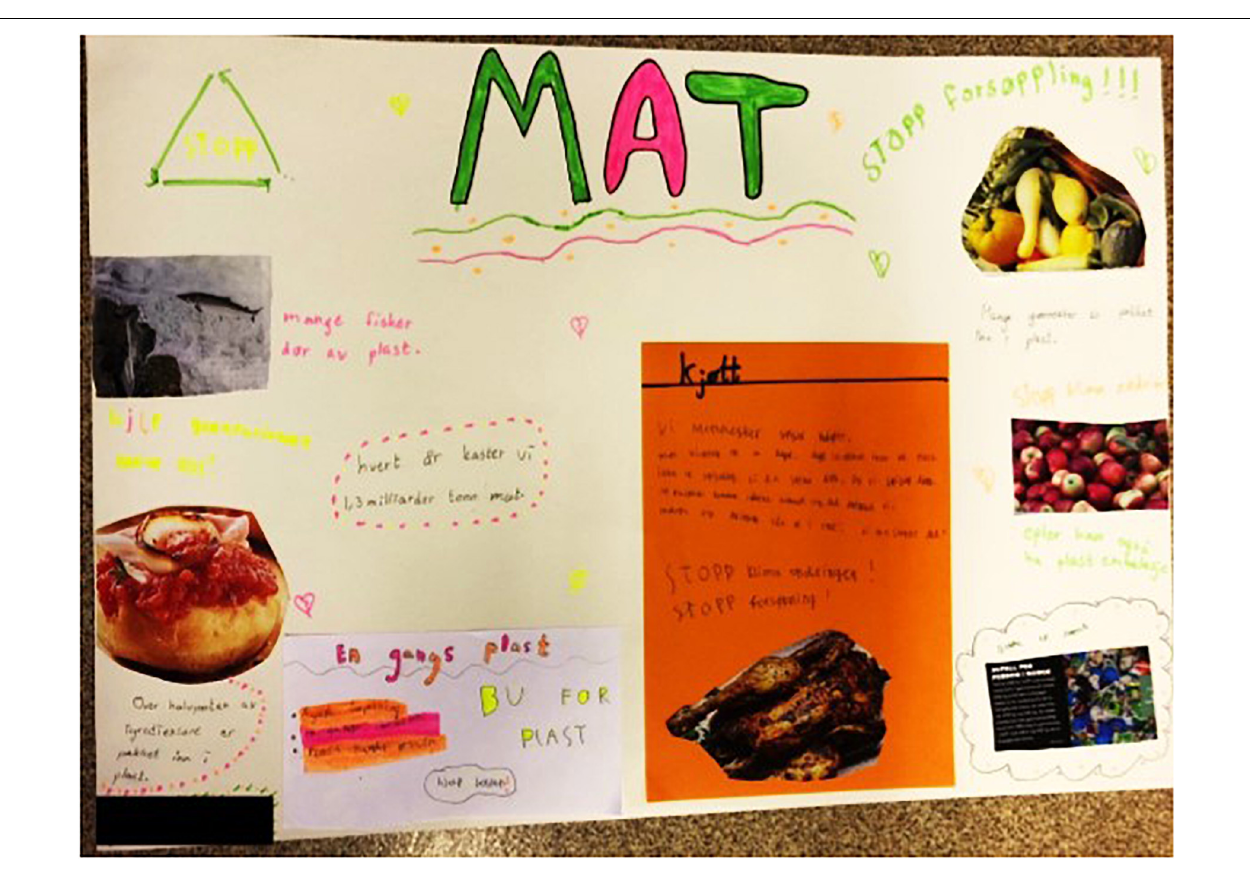
FIGURE 5 | Example of creative engagement with the frame “grocery store” ( mat means food in